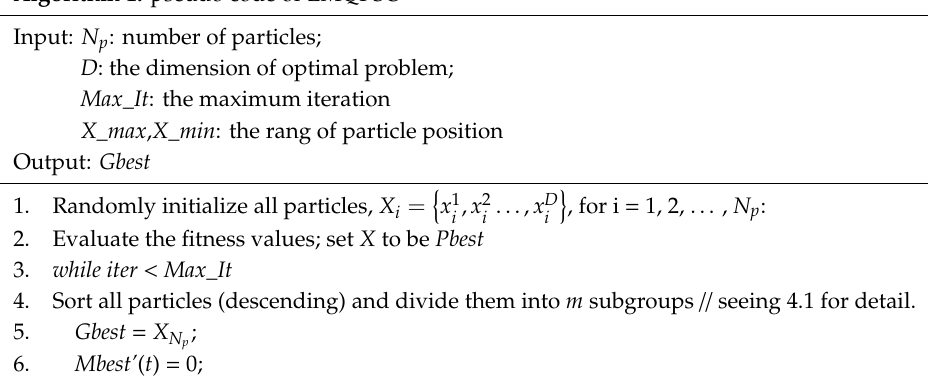
Algorithm 1. pseudo code of